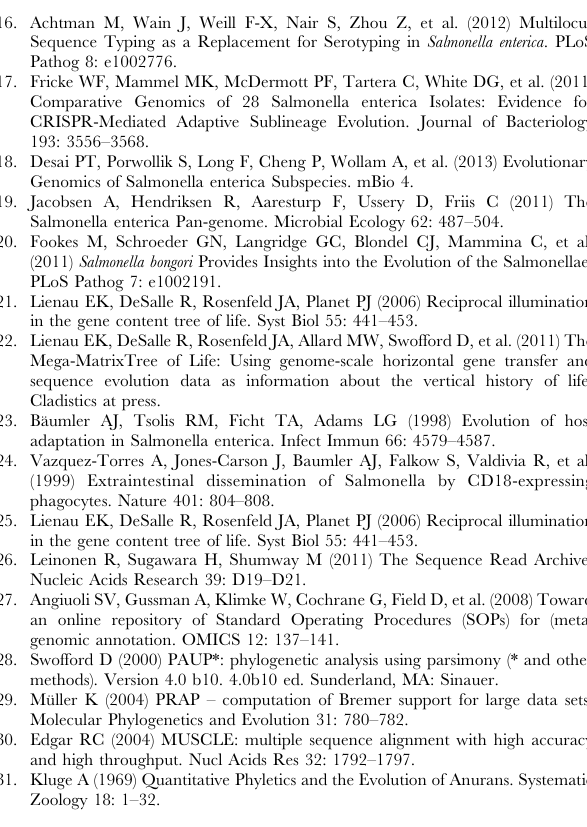
Figure S2 Majority Rule Bootstrap consensus tree of